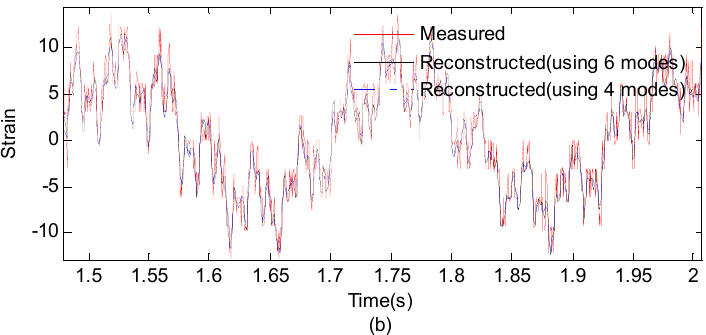
Figure 21. ( a ) Measured strain responses and reconstructed responses using six modes and four modes; (0~4 s) ( b ) Results are concentrated on 1.5~2 s for clear presentation.